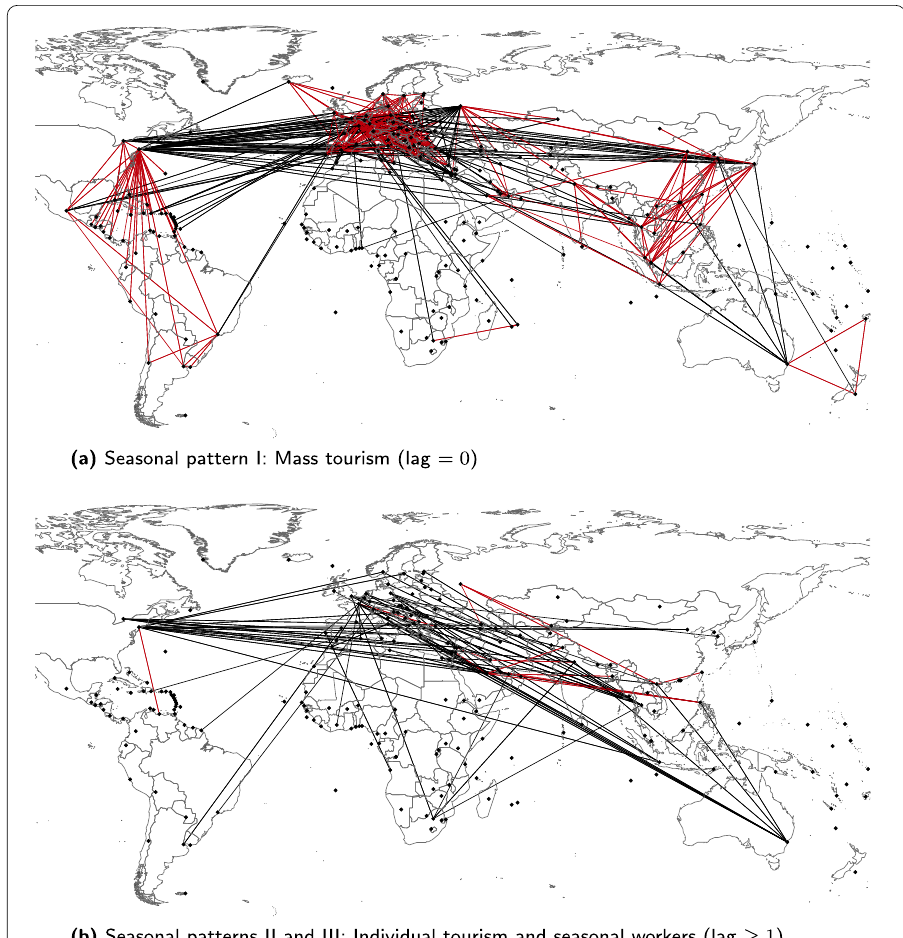
Figure 10 Mapping structural differences between seasonal patterns of transnational human mobility. To increase clarity, only country pairs with seasonal effects with a highly significant cross-correlation ( p < 0.01) and a main peak consisting of at least 5000 passengers are shown. Red ties denote intraregional mobility, black ties denote interregional mobility (based on CEPII’s GeoDist